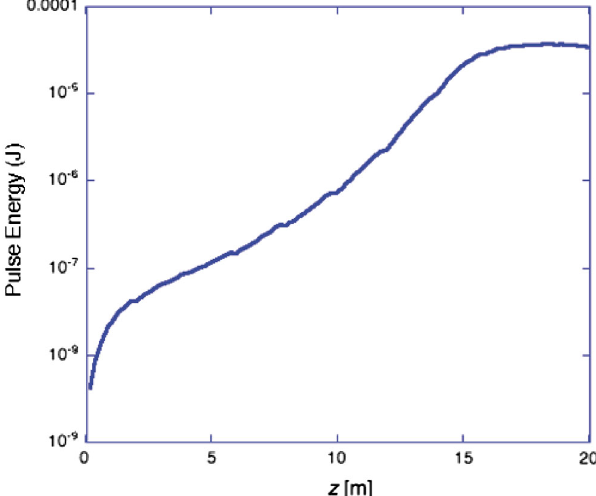
FIG. 10. Simulation of FEL energy evolution with beam current profile and transverse phase space as in Fig. 9(a), and λ ¼ 9 mm, undulator, and 14.1 GeV beam energy, lasing with u central wavelength 0 . 155 Å (80 keV